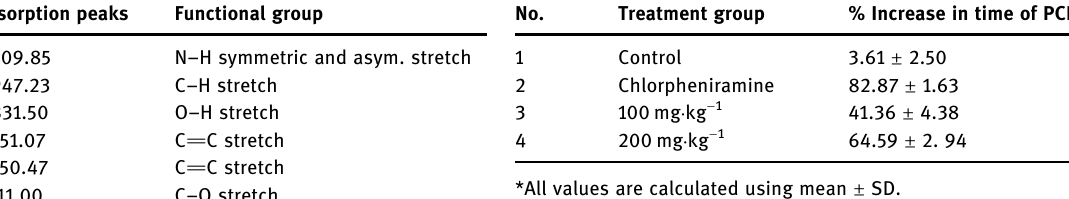
Table 6: Histamine - induced bronchoconstriction